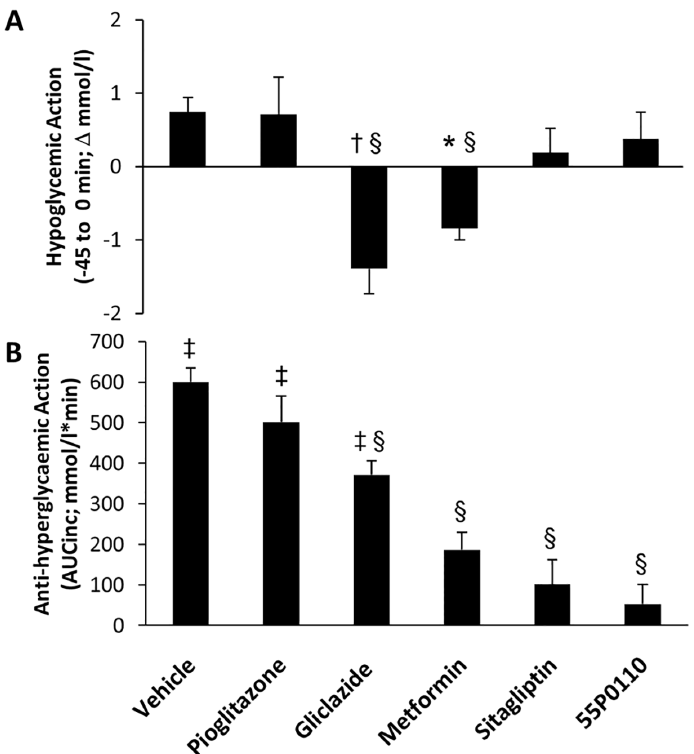
Fig 6. Comparison of 55P0110 to established anti-diabetic drugs — hypoglycaemic and anti- hyperglycaemic properties in mice. Vehicle, pioglitazone (30 mg/kg), gliclazide (8 mg/kg), metformin (200 mg/kg), sitagliptin (10 mg/kg), or 55P0110 (90 mg/kg) were orally administered to mice 45 min before a standard oral glucose tolerance test was started (3 g/kg). ( A ) Change in basal glycaemia 45 min after drug feeding ( „ hypoglycaemic action “ ); ( B ) incremental area under the glucose curve (AUCinc; „ anti- hyperglycaemic action “ ). Means ± SEM; n = 8 – 27 each; * p < 0.05; † p < 0.01; ‡ p < 0.001 vs. 55P0110; §p < 0.05 vs.